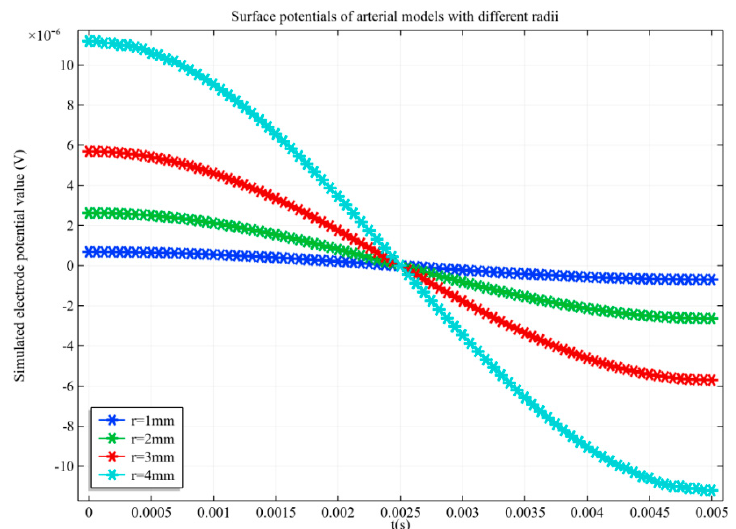
Figure 15. The electrode potential signal during a scanning cycle with different r .